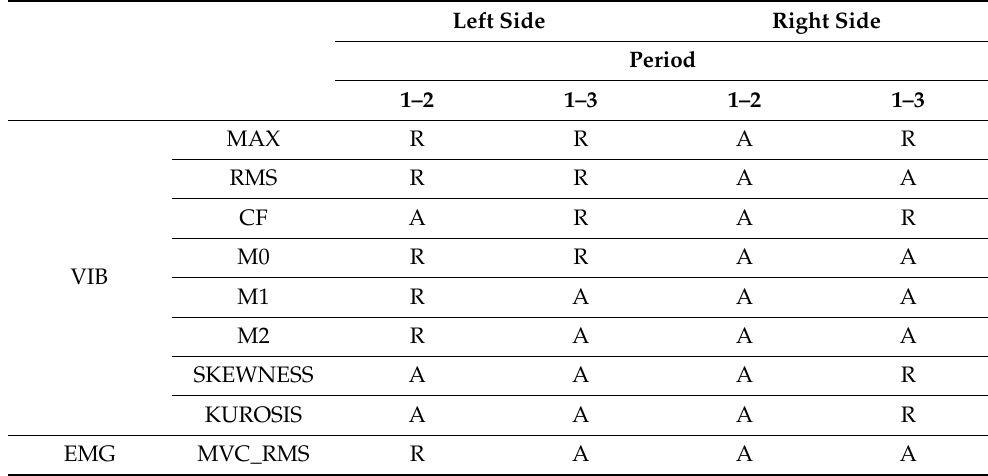
Table 1. Statistical significance of differences between the individual stages of rehabilitation (R—there is a difference, A—there is no